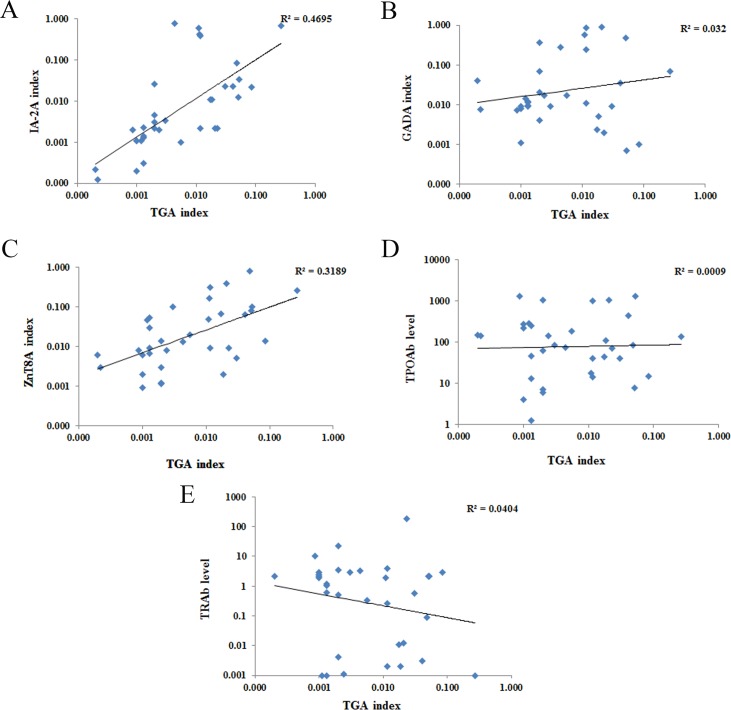
Correlation between TGA index and anti-islet autoantibody index among patients with APS3v.A-C represents correlation between TGA and IA-2A, GADA, ZnT8A, respectively; D-E shows the correlation between TGA and TPOAb, TRAb, respectively.